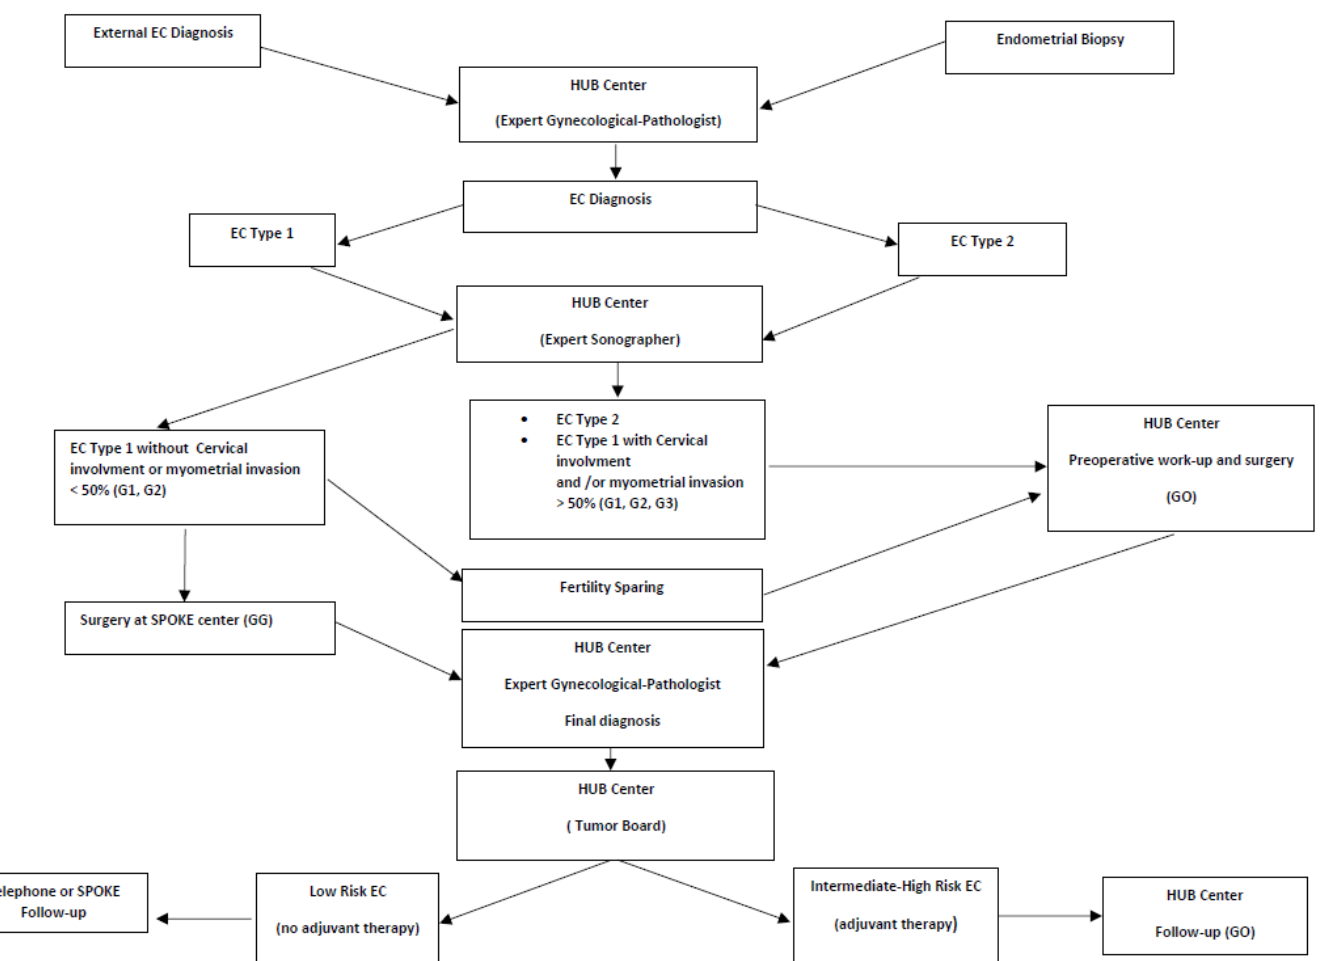
Figure 1. Preoperative work-up and centralization of endometrial cancer patients.